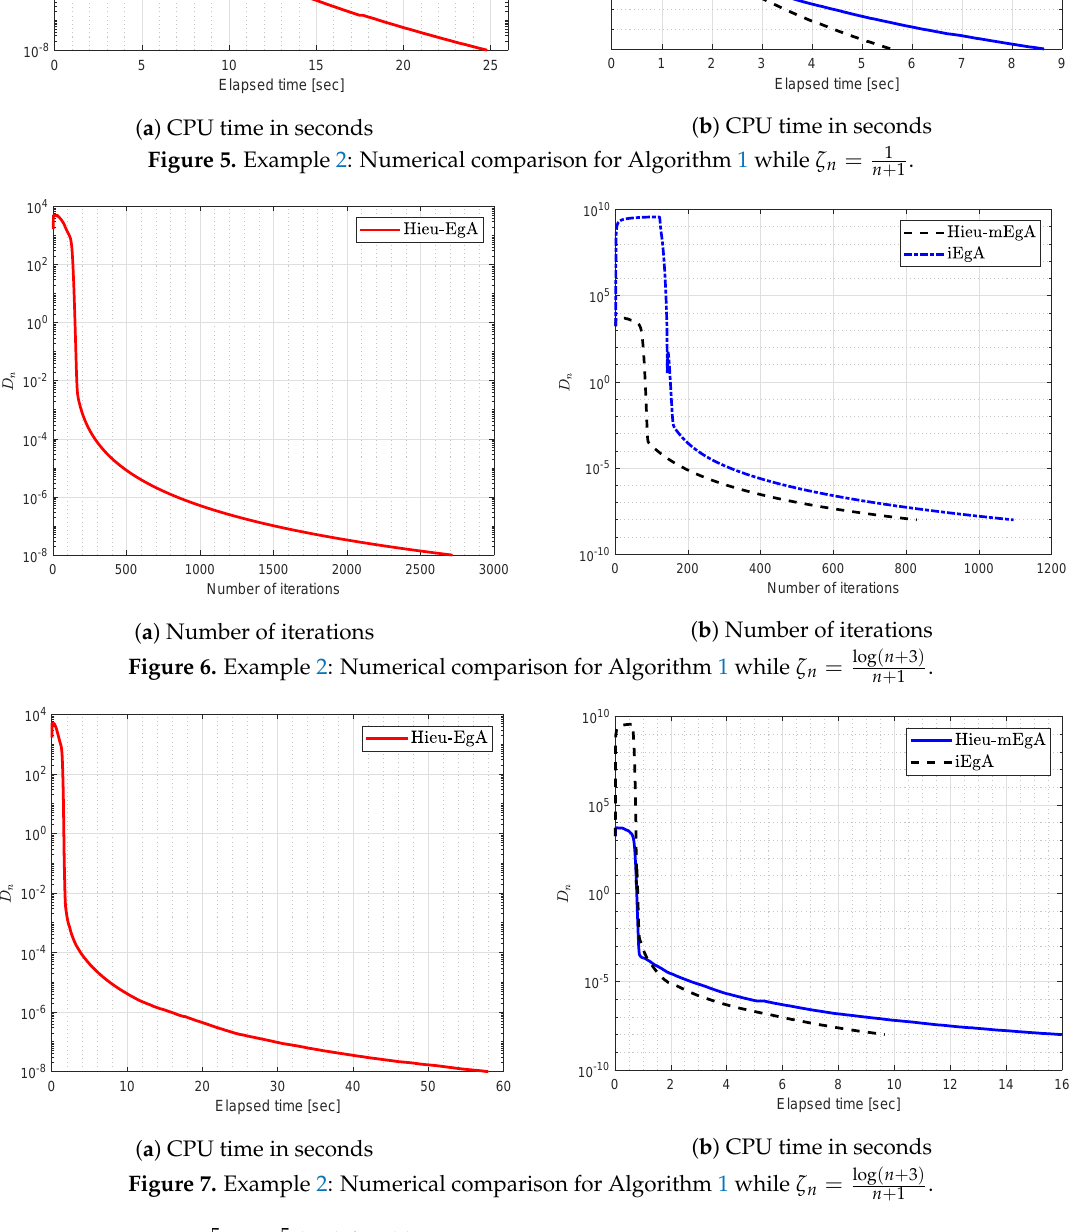
Figure 7. Example 2: Numerical comparison for Algorithm 1 while ζ n = log